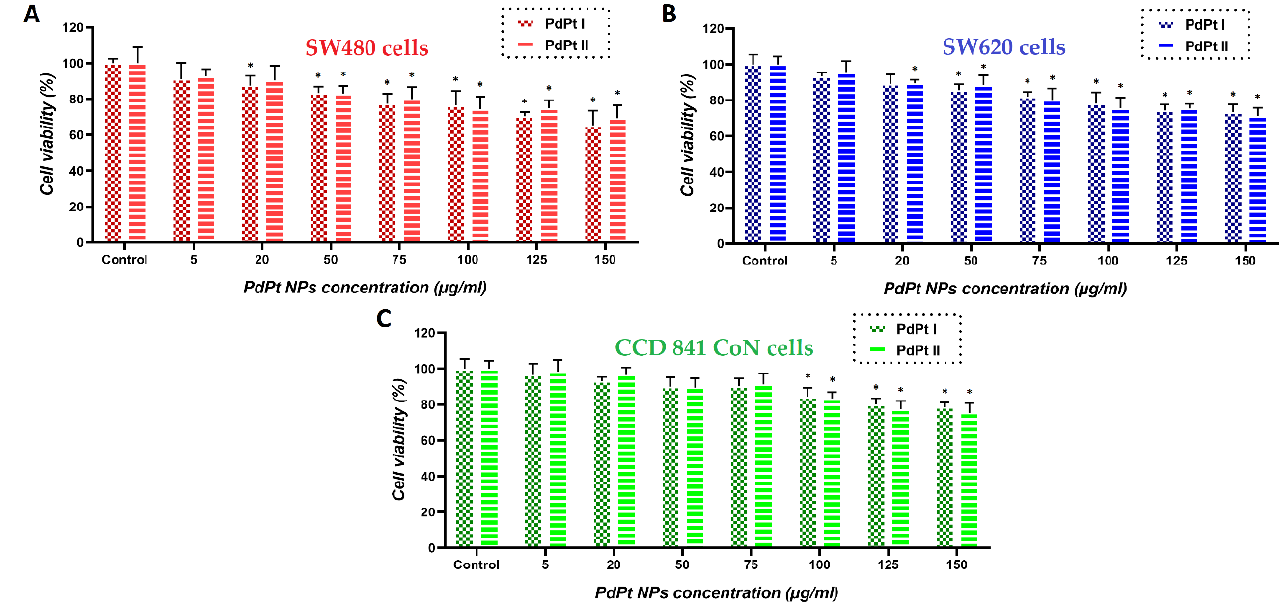
Figure 5. Cytotoxicity of PdPt (I) and PdPt (II) NPS against ( A ) SW480 (red bars), ( B ) SW620 (blue bars) and ( C ) CCD 841 CoN green bars) cells after 18 h of incubation. Differences were considered significant when * p -value < 0.05 vs. control.